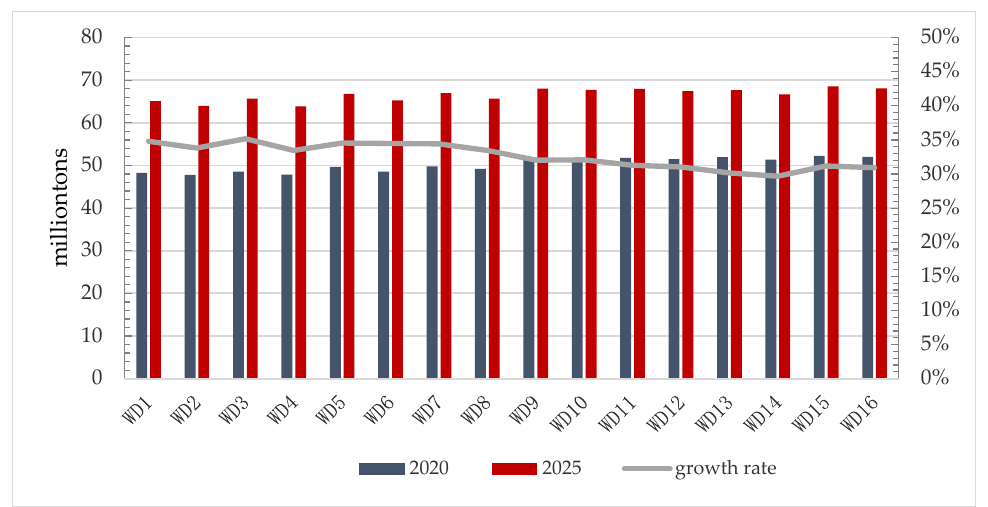
Figure 7. The predictions of power CO 2 emissions for the strengthened development scenario in 2020 and 2025.